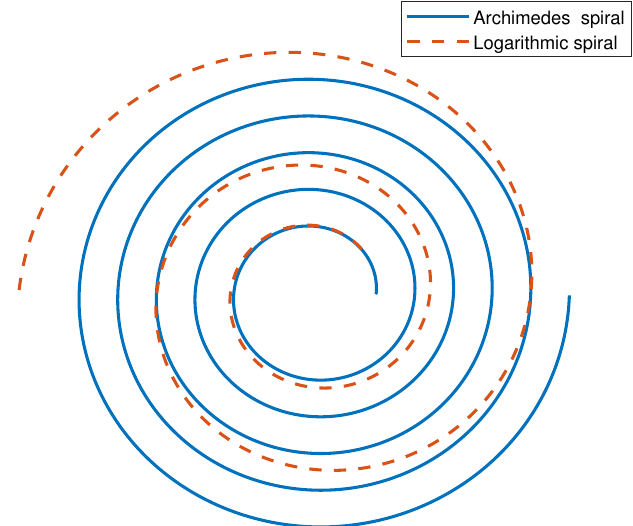
Figure 3. The curves of an Archimedes spiral and a logarithmic